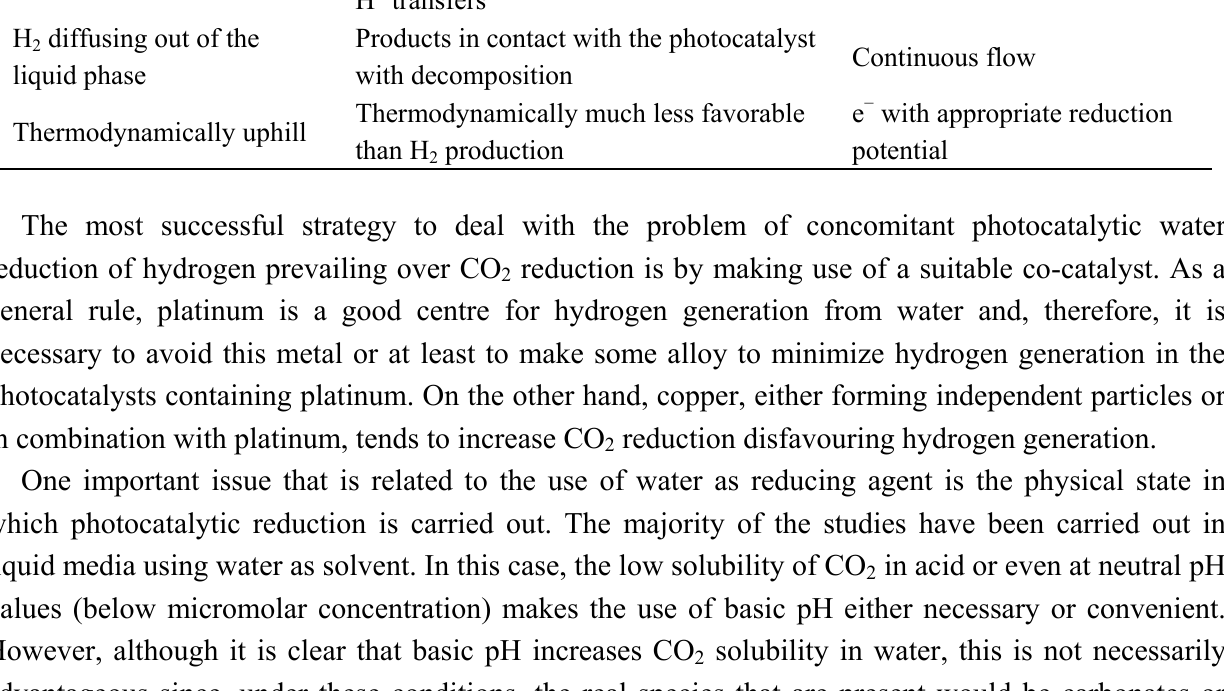
Table 1. Some differences between photocatalytic H